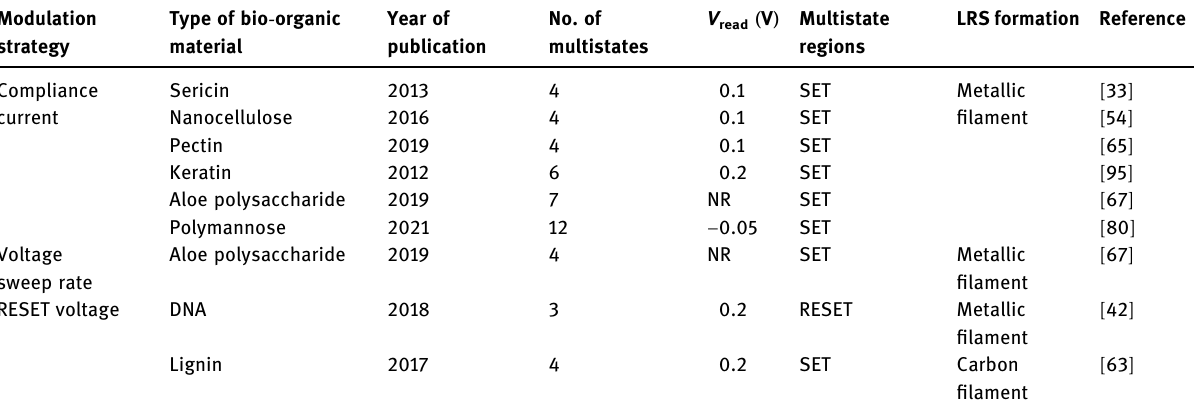
Table 8: Summary of multistate bio - organic - based RRAMs ( modi fi ed from [ 80 ])